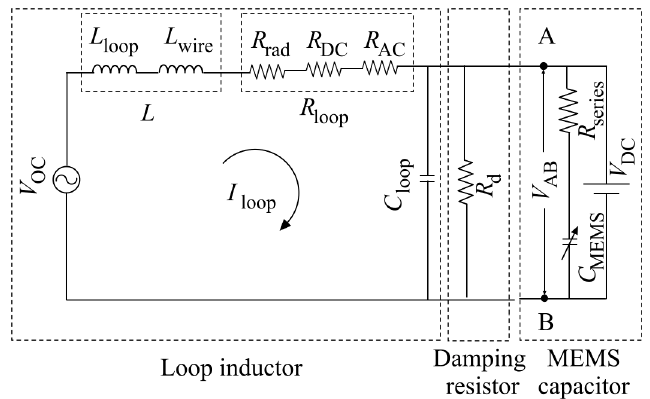
Figure 3. Electrical equivalent circuit of the MEMS UWB power sensor.